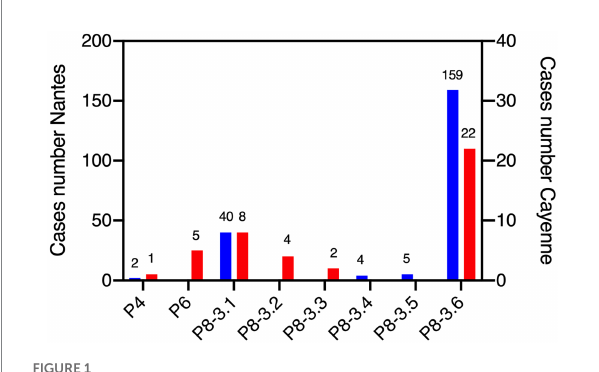
FIGURE 1 Distribution of rotavirus P genotypes at Nantes and Cayenne. Sequences of the VP4 protein region allowed for classification. Blue bars represent the number of cases in Nantes and red bars represent the number of cases in Cayenne. Number of sequences is shown above bars. All available P genotypes are shown, regardless of the availability histo-blood group antigen (HBGA) or clinical severity